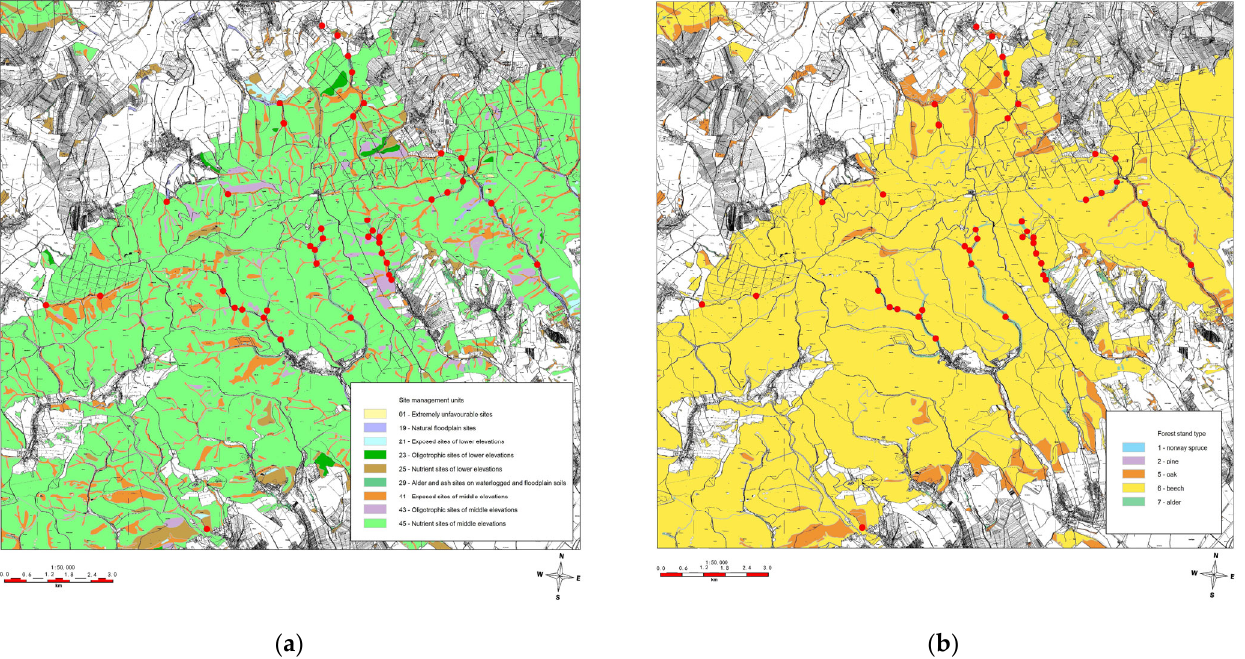
Figure 4. Area of C. heros occurrence with units of forest management: ( a ) management site units; ( b ) forest stand types.